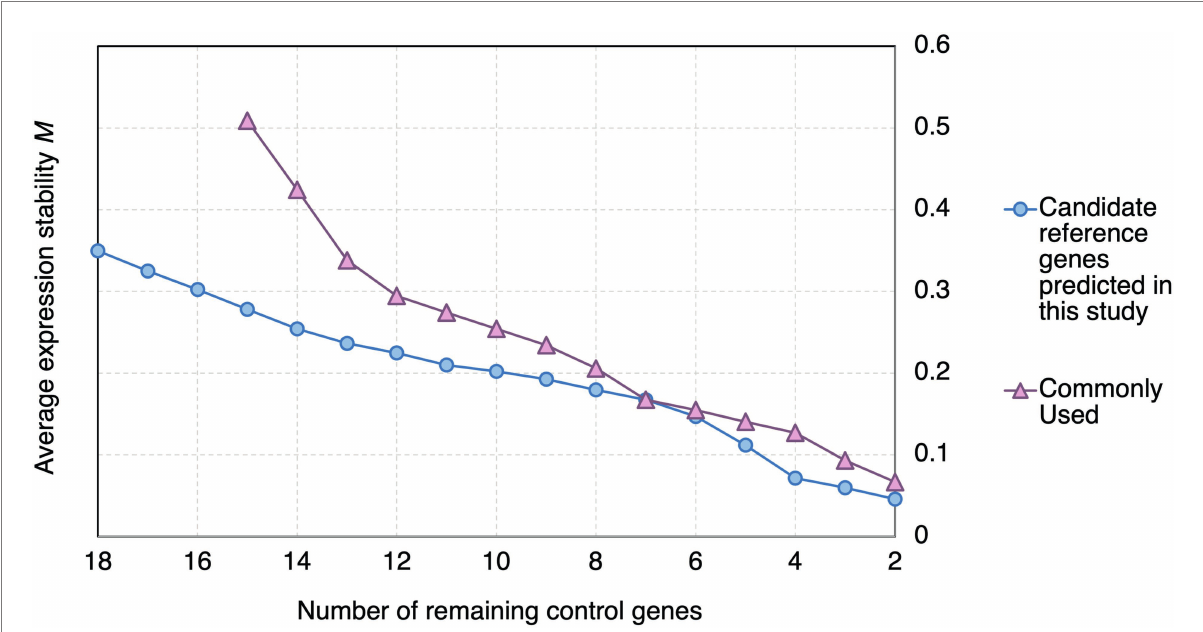
FIGURE 3 geNorm analysis of the average stability values of the candidate reference genes predicted in this study and reference genes commonly used in previous studies upon Pst DC3000 infection. Average expression stability values ( M ) of the remaining control genes during the step exclusion of the least stable control among the reference gene candidate upon Pst DC3000 infection using geNorm. The higher the average M , the lower rank of the expression stability of the reference gene